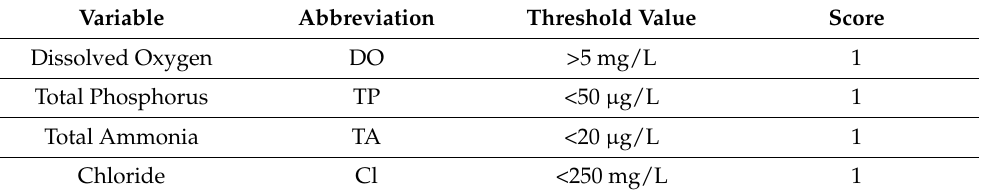
Table 2. Variables, thresholds, and scores to assess water quality based on the US-EPA [46].